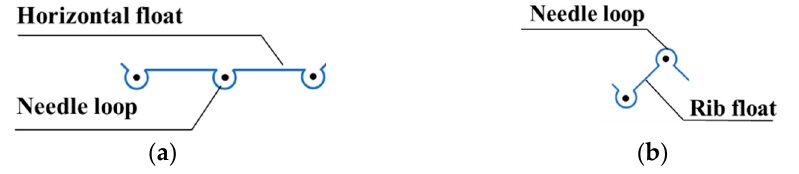
Figure 3. Graphical notation of the needle loop, ( a ) horizontal float and ( b ) rib float. Figure 2. Graphical notation of the needle loop, ( a ) horizontal float and ( b ) rib